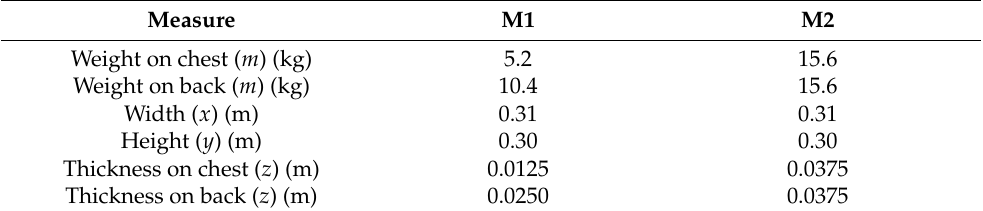
Figure 1. ( a ) Overview of the agility run with five flags and five (low) hurdles. The starting line is on the right side of the image and the finishing line on the left side. ( b ) Subject is jumping over one of the hurdle obstacles. Table 1. Specifications of the external load segment for the two loaded conditions (M1 and M2).